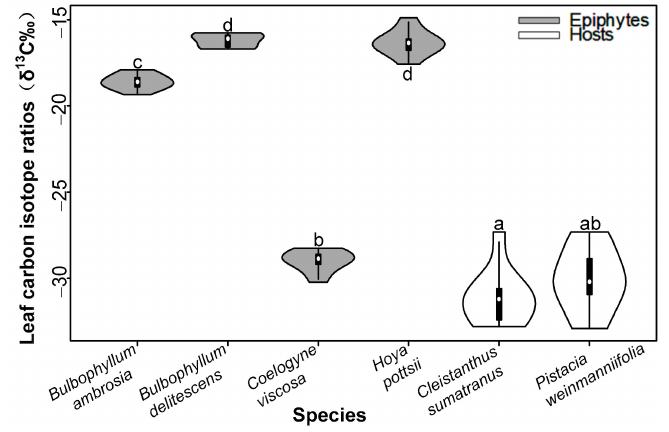
Figure 2. Carbon isotope ratios ( δ 13 C) of mature leaves collected from epiphytes and host tree species during the dry season. Lines within boxes are means, bars are ± SE. n = 10, except for B. delitescens ( n = 6). Letters represent significant differences at p <